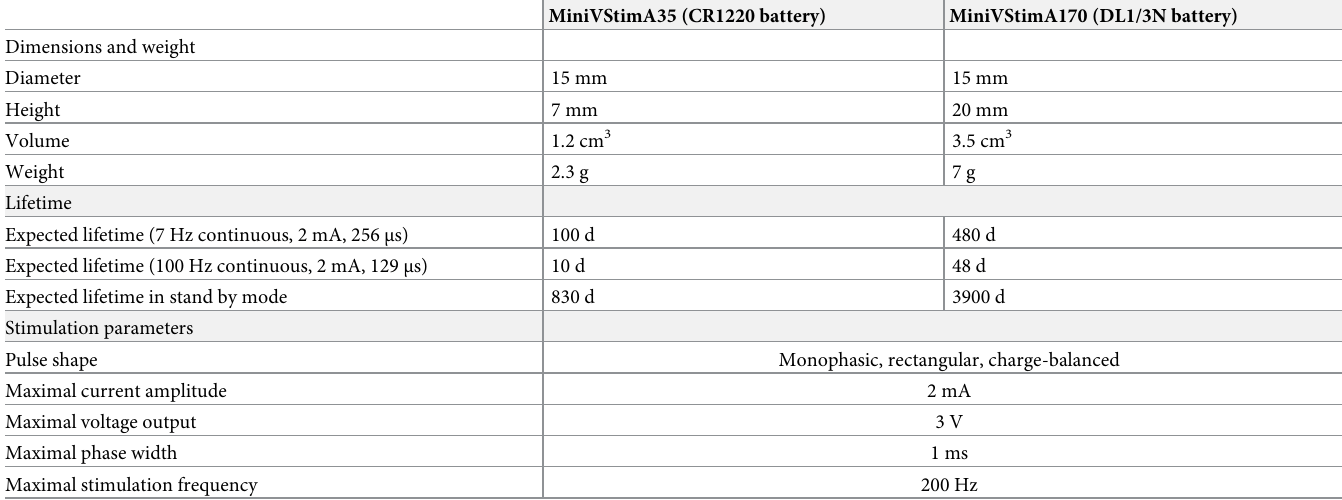
Table 1. Implant specifications of the MiniVStimA35 and